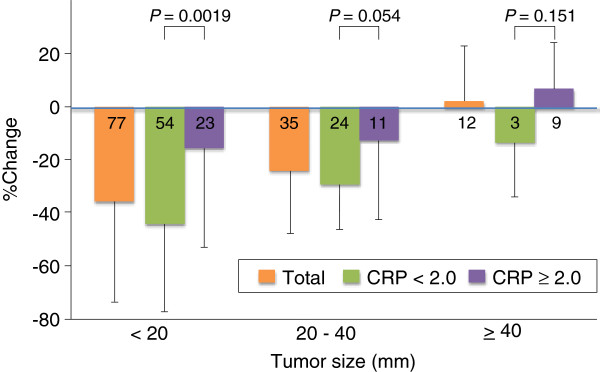
Influence of CRP on percent change in lung lesion size. In patients with lung lesions < 20 mm, the percent reduction in size was significantly greater in patients with low, compared with high, CRP levels. Meanwhile, CRP level had a marginal effect on size reduction in lesions ≥ 20 to < 40 mm, and no effect in lesions ≥ 40 mm.